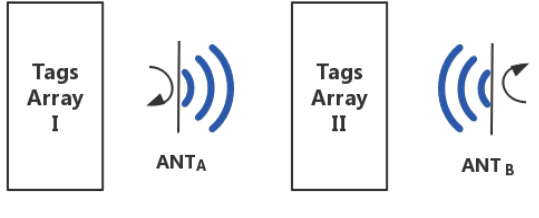
Figure 4. Principle analysis.